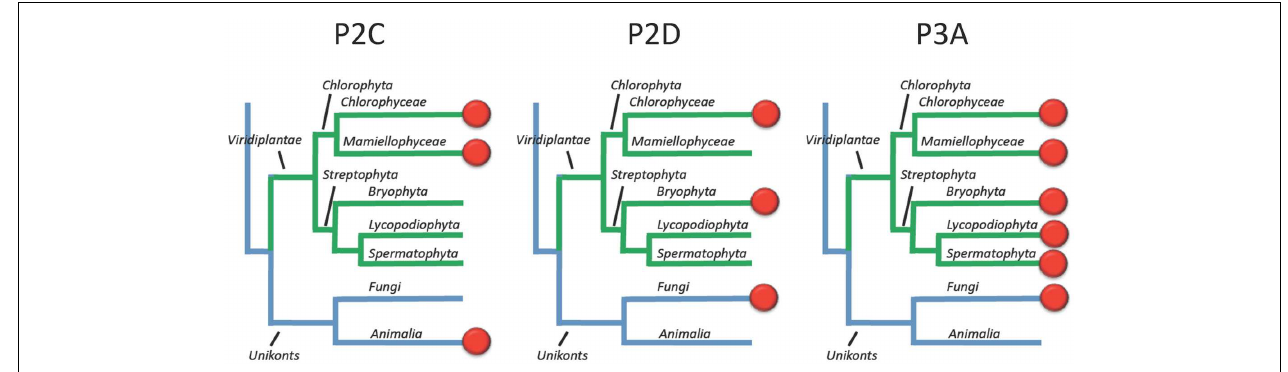
FIGURE 15 | Overview of the evolution of Na + and H + transporting P-type ATPases inViridiplantae. Most likely, the ancestor of green plants had two types of Na + pumps (P2C and P2D) in addition to a plasma membrane H +